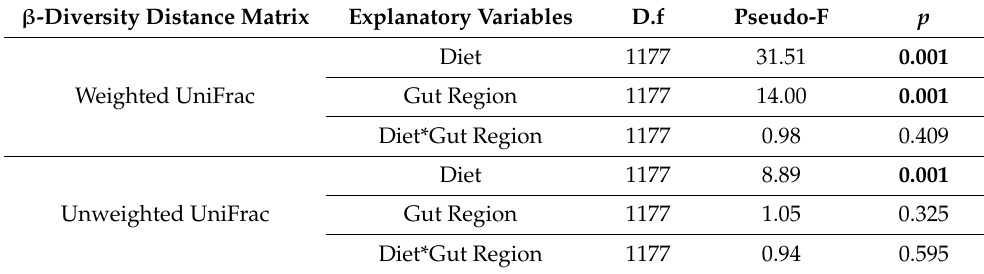
Table 3. Permutational ANOVA (PERMANOVA) exploring the effects of diet, gut region, and their interaction in beta diversity indices of bacterial community of European seabass juveniles fed with control diet or supplemented with Allium- derived PTSO. D.f. refers to degree of freedom. Significant p -values are shown in bold. β -Diversity Distance